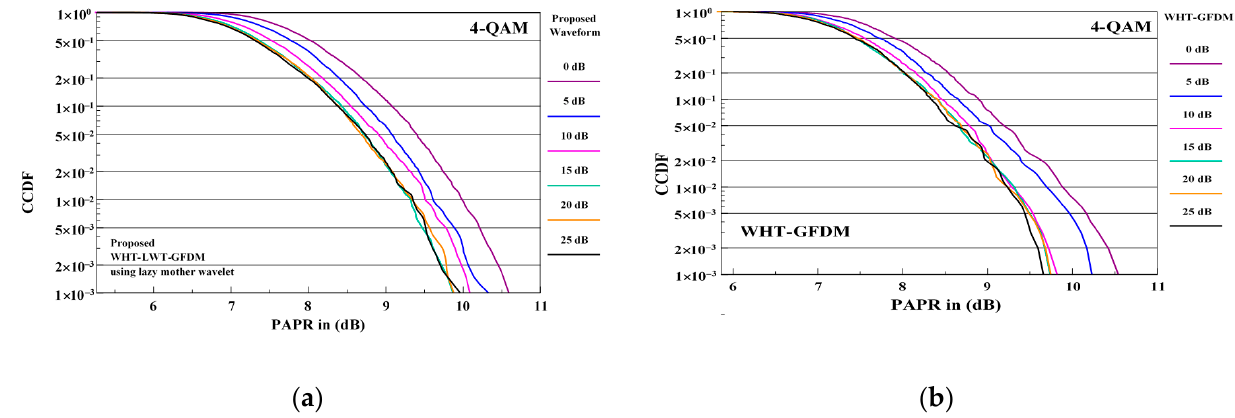
Figure 13. The PAPR performance comparison of the proposed waveform ( a ) and WHT-GFDM waveform ( b ) in between 0–25 dB of SNR values for 4-QAM modulation.